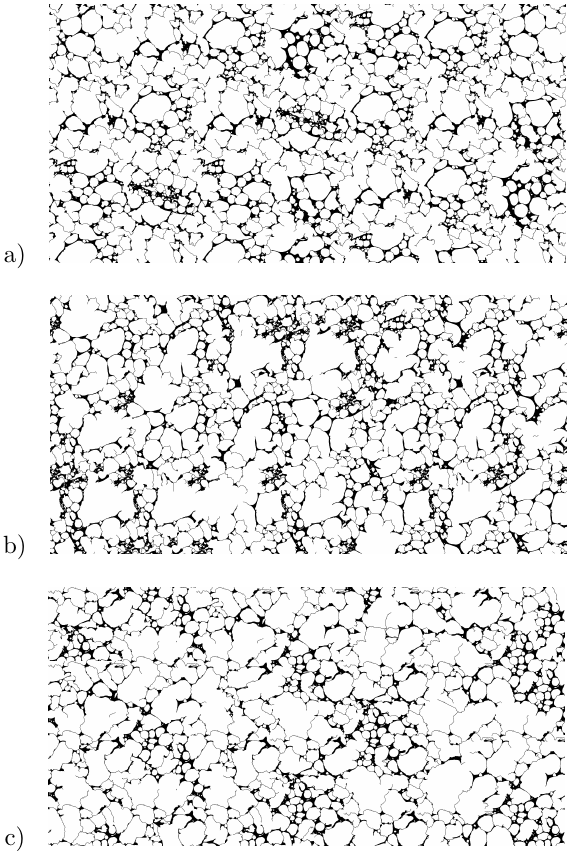
Figure 13. Examples of synthesized domains by means of tile sets, a) W8/2-2, b) W16/2-2 and c)